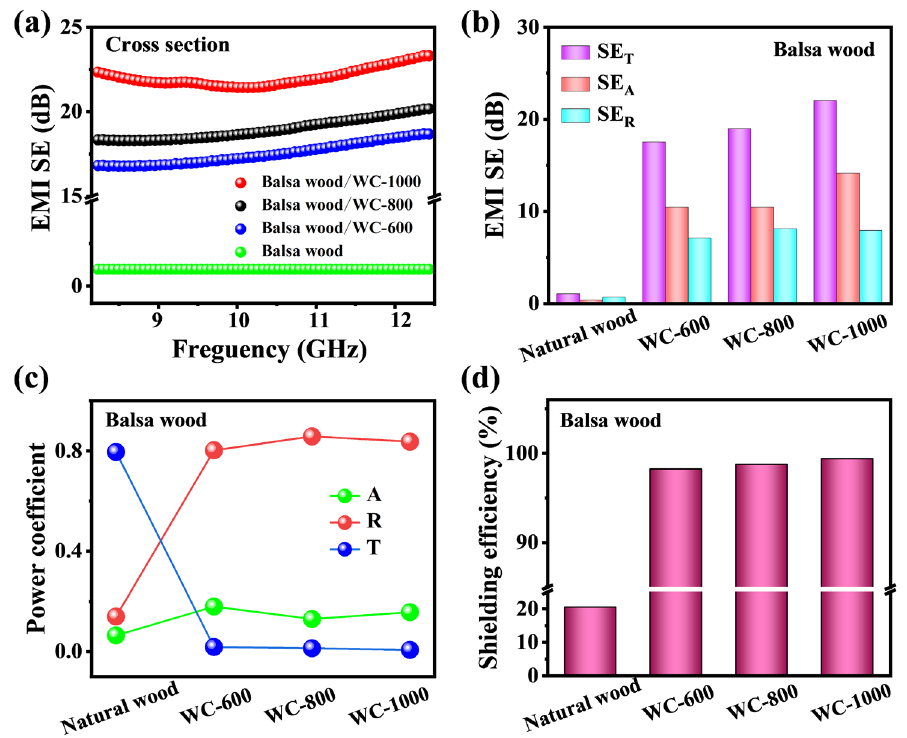
Figure 4. ( a ) EMI SE T ; ( b ) comparison of the average SE T , SE A and SE R values; ( c ) the A, R and T values and ( d ) EMI shielding efficiencies of natural wood, WC-600, WC-800 and WC-1000 of balsa wood.